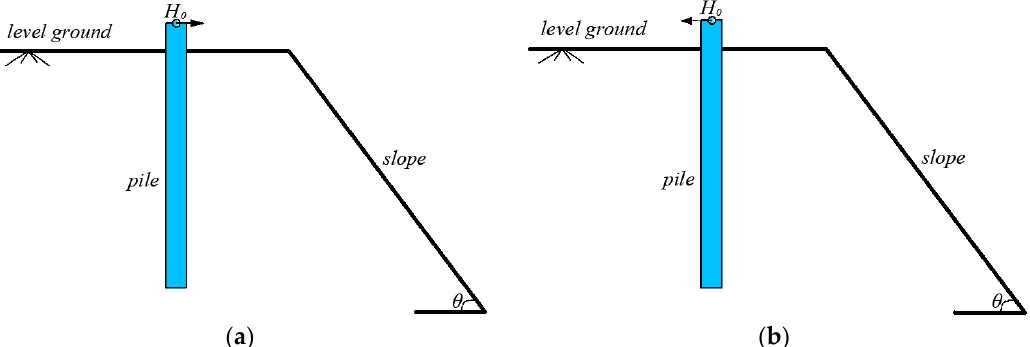
Figure 1. The direction of the lateral load acting on the pile foundation: ( a ) forward loading; ( b ) reverse loading.